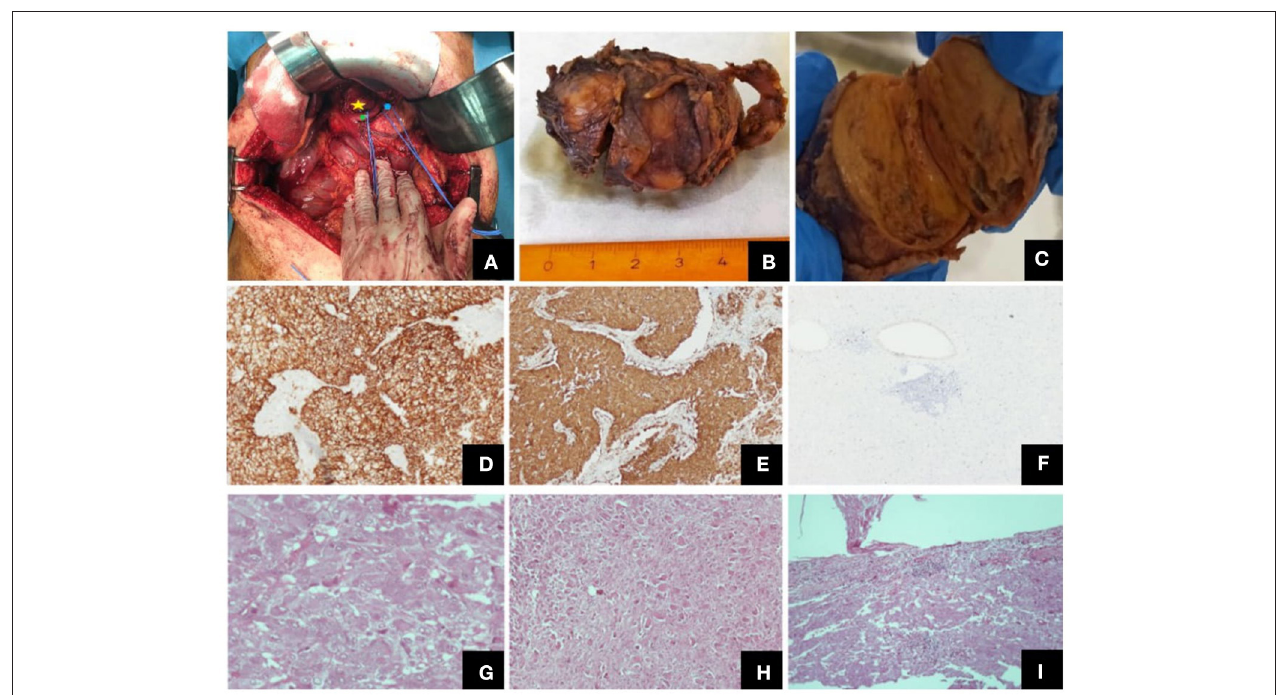
FIGURE 1 | Different views of the tumor (intraoperatively, macroscopically after excision) and its histological features. (A) Intraoperative view of the tumor (yellow star: the tumor, green point: common hepatic artery, blue point: left gastric artery), (B) Macroscopic view of the excised tumor, (C) Tumor on vertical cross-section, where both the paraganglioma and the ganglioneuroma components were identified, Representative images of histological features: (D) CD56, × 100, (E) synapt ( × 100), (F) Ki67 labeling index ( × 40), (G) paraganglioma, H + E, ( × 400), (H) ganglioneuroma, H + E, ( × 100), (I) tumor invasion of the capsule, H + E, ( ×